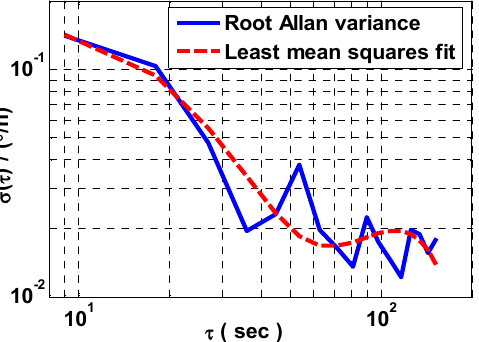
Figure 2. AVAR result of x and z gyros measured data processed by the FRIS